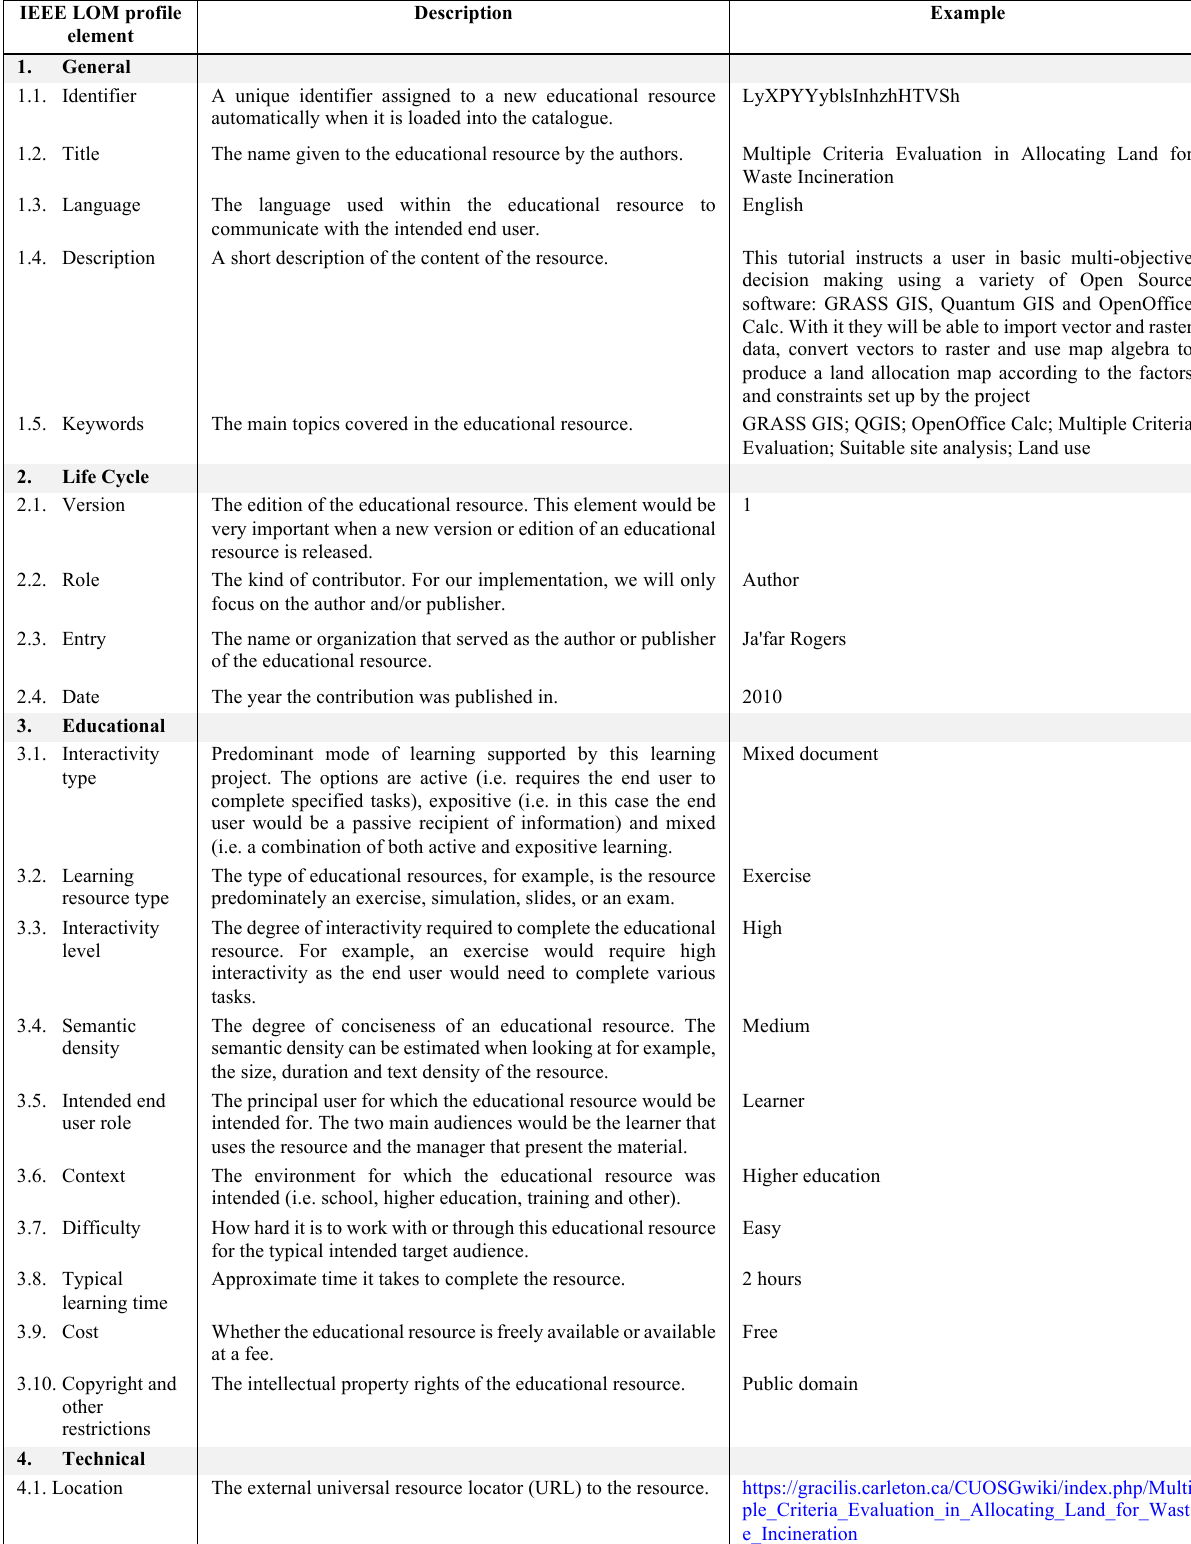
Table 1. Overview of the IEEE LOM elements selected for the profile. Adapted from IEEE